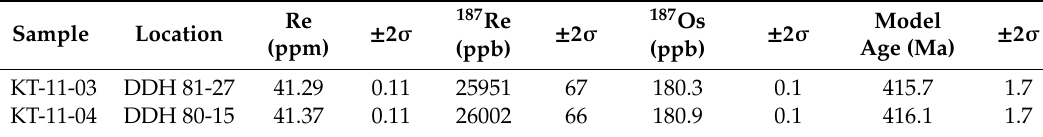
Table 5. Isotope dilution thermal ionization mass spectrometry (ID TIMS) analyses of 187 Re and 187 Os in molybdenite from sample KT-11-03 and KT-11-04, KT-11-03: Model Age = 415 ± 1.7 Ma (2 σ ), KT-11-04: Model Age = 416.1 ± 1.7 Ma (2 σ ).